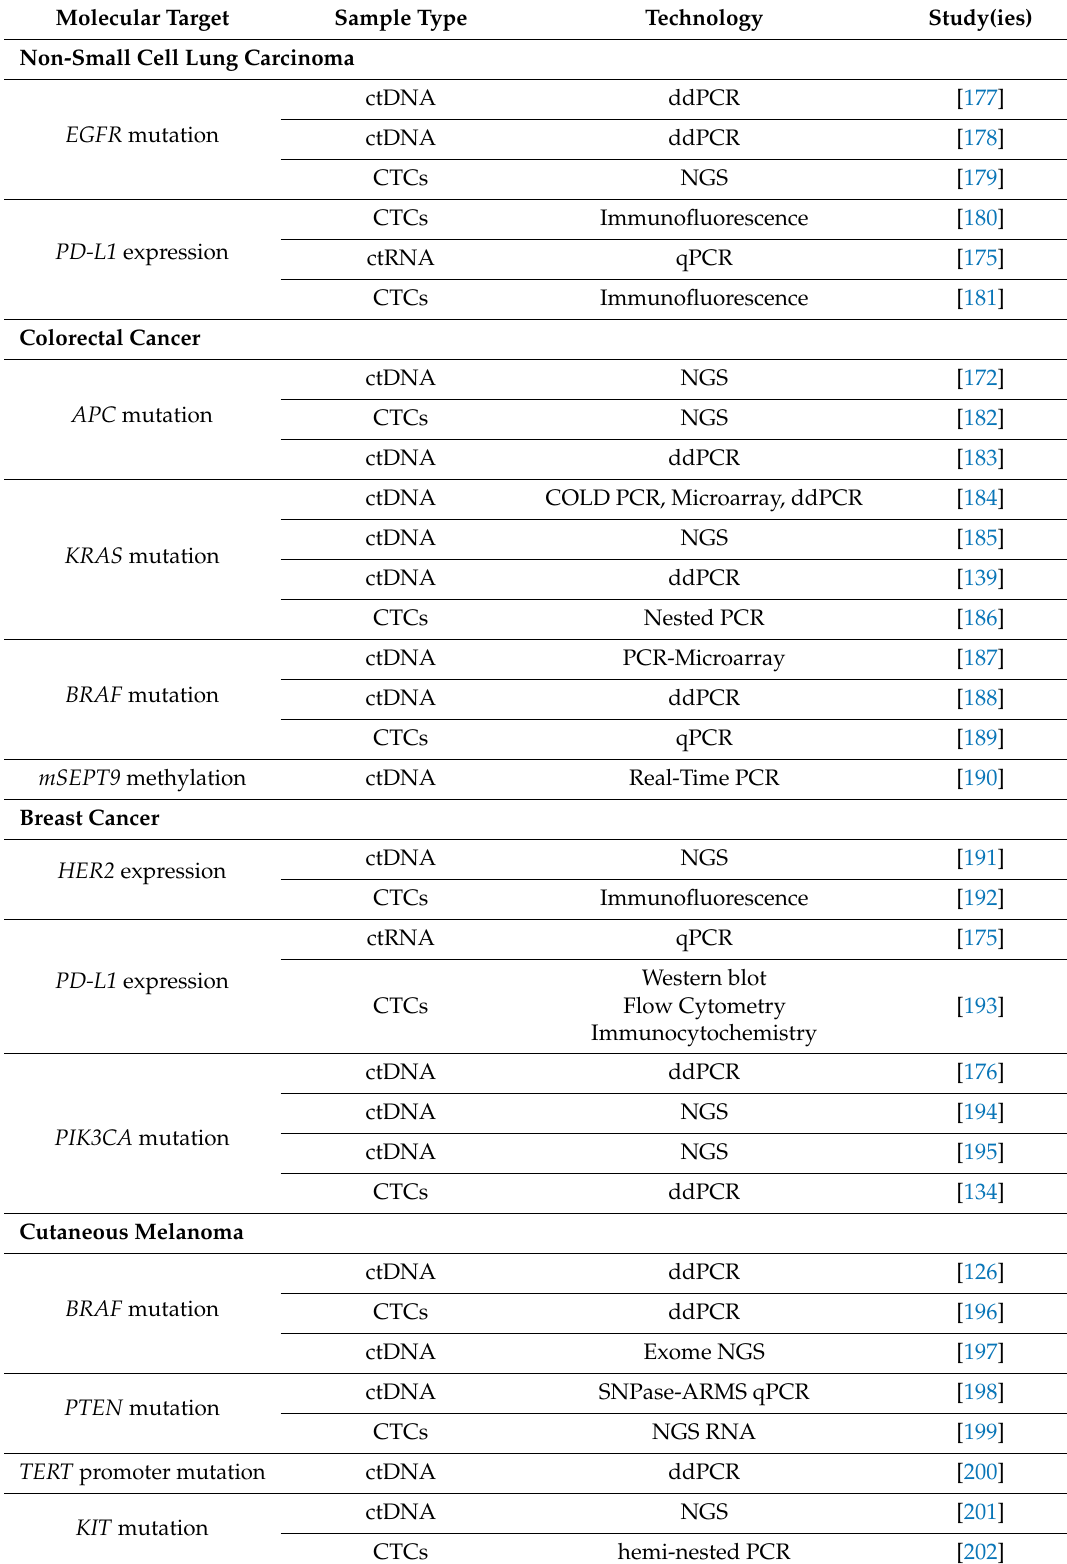
Table 3. Overview of the most relevant ctDNA and CTCs analyses in di ff erent cancer